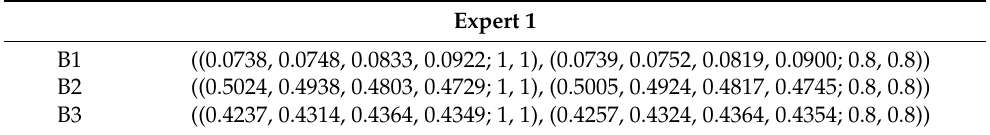
Table 5. Expert 1’s fuzzy weights for the evaluation of secondary indicators under the absorptive capacity dimension.